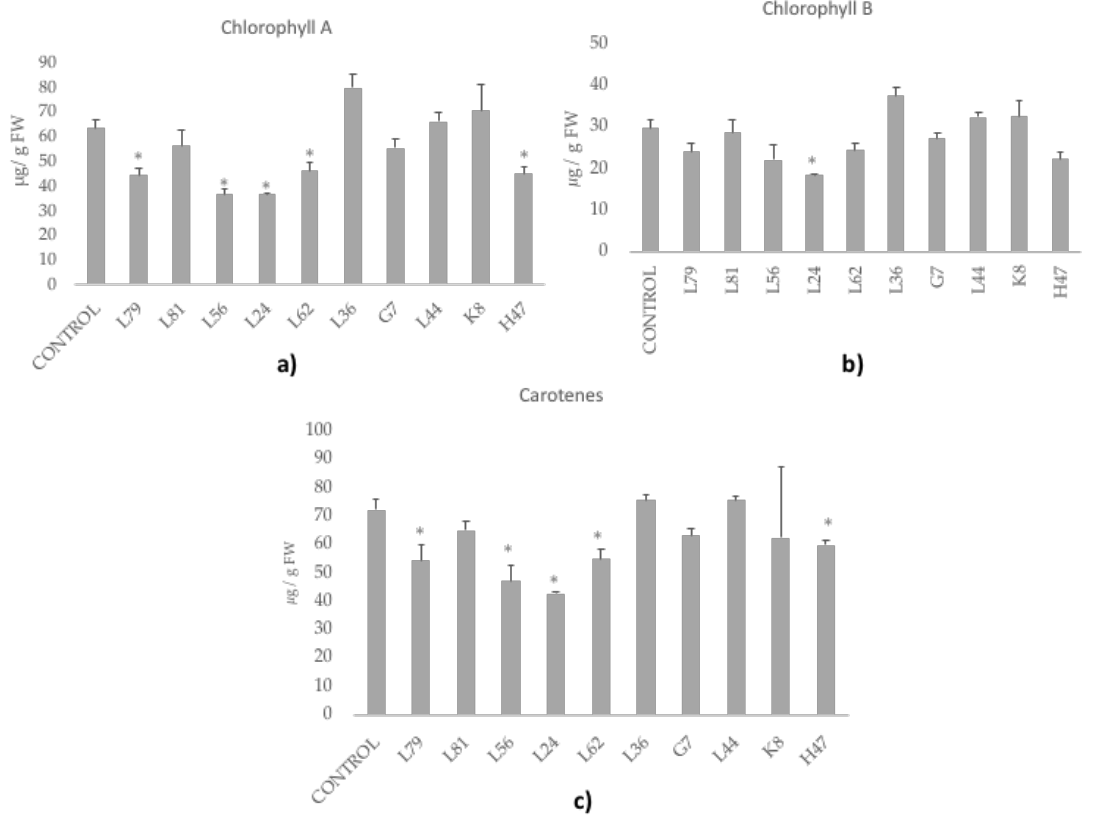
Figure 4. Photosynthetic pigments concentration (µg/g FW). ( a ) Chlorophyll a, ( b ) Chlorophyll b and ( c ) Carotenoids were measured in olive tree leaves treated with the ten strains. For each treatment and parameter average value ± standard error value is presented ( n = 6). Asterisks (*) represent significant differences with the control according to the LSD test ( p < 0.05).